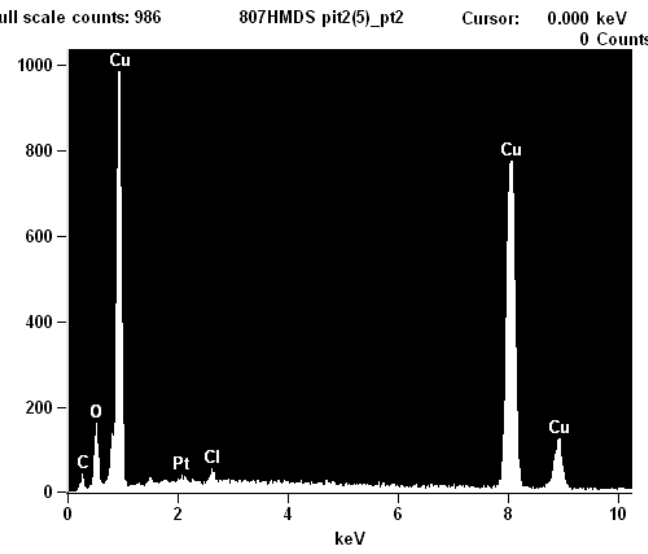
Figure 13. EDS (Energy Dispersive Spectroscopy) analysis of the microbes inside the pit shows only Cu, C, O and Cl.